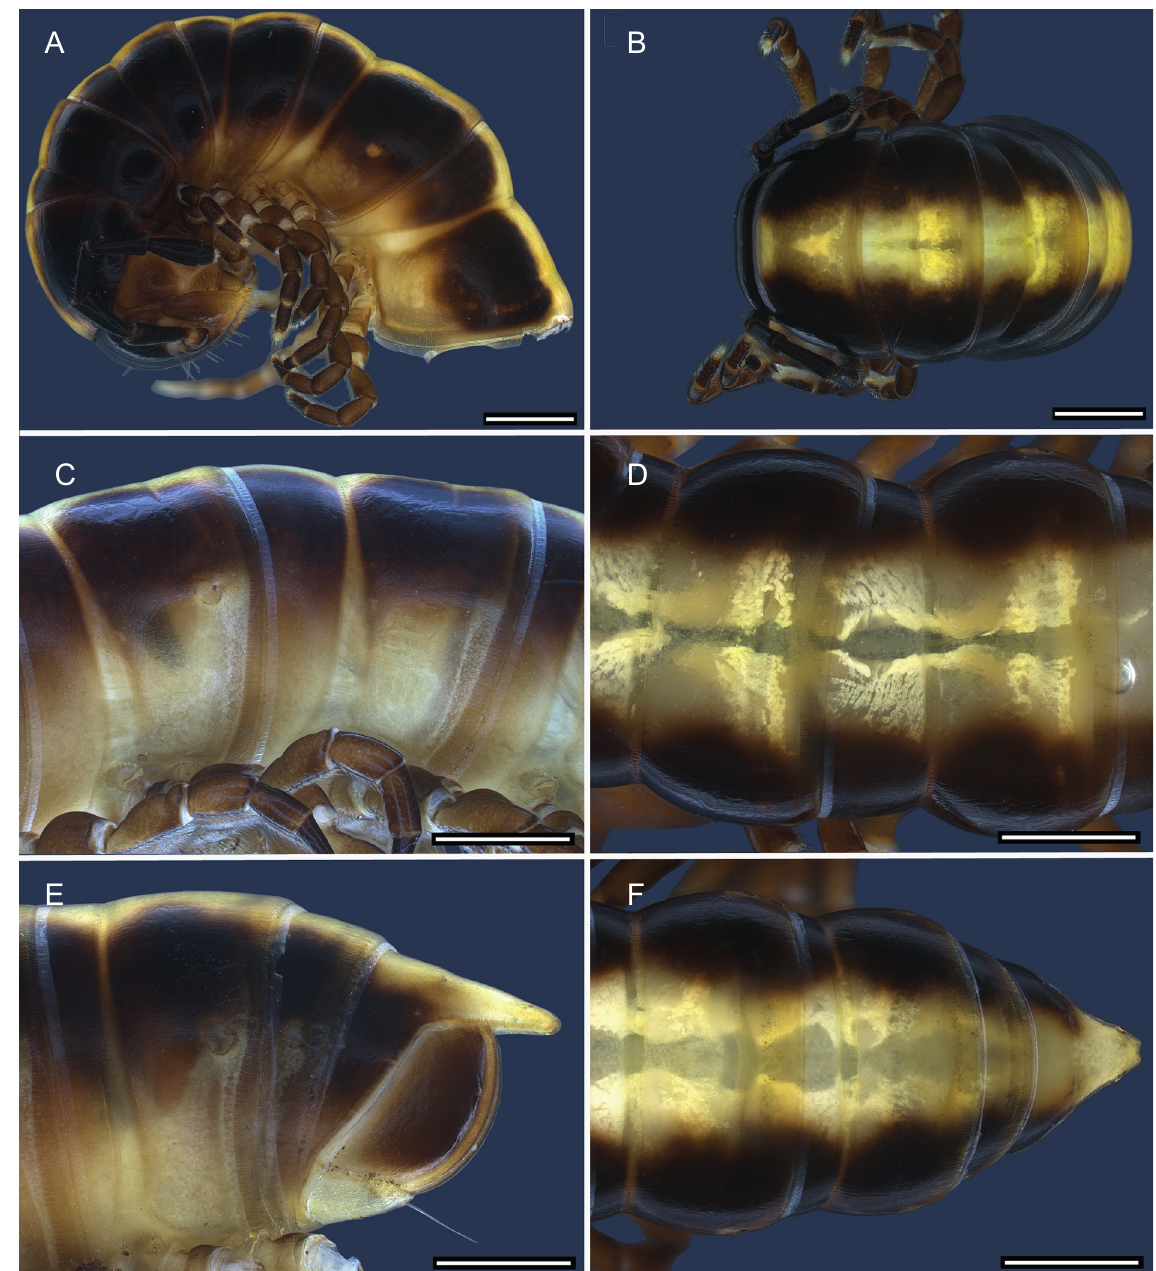
Fig. 12. Pogonosternum adrianae Jeekel, 1982, male from Moe-Walhalla Road (NMV K-12207). A – B . Anterior rings. A . Left lateral view. B . Dorsal view. C – D . Rings 10 and 11. C . Left lateral view. D . Dorsal view. E – F . Posterior rings. E . Left lateral view. F . Dorsal view. Scale bars: 1